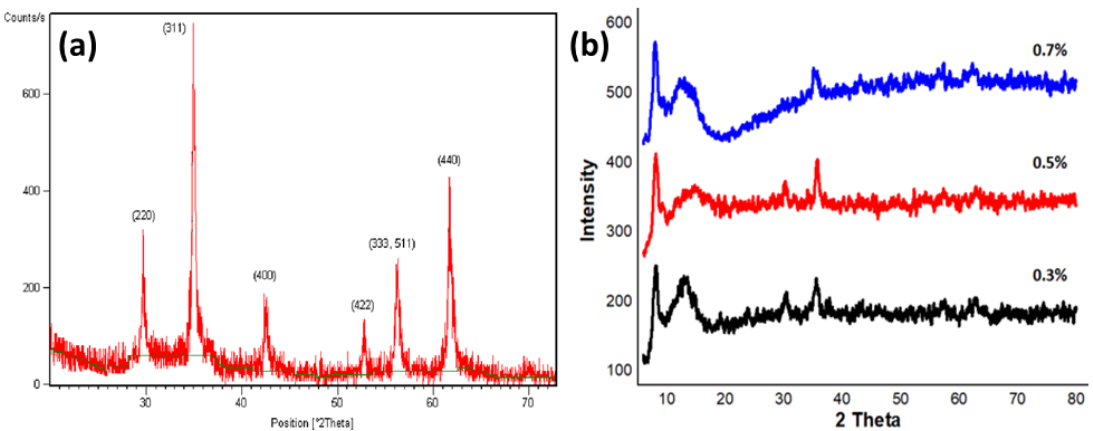
Figure 5. XRD pattern of ( a ) pure manganese ferrite powder and ( b ) S@Mn(Fe 2 O 4 ) composite (0.3, 0.5, 0.7 %).